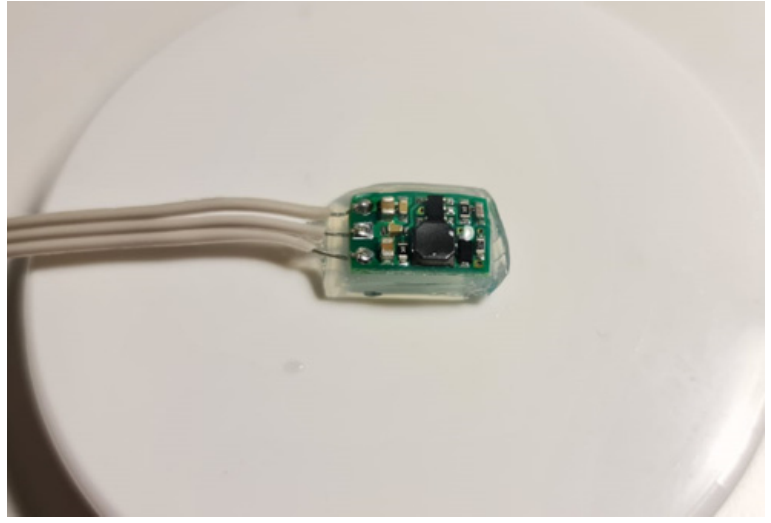
Figure 2. GelMa-encapsulated device.